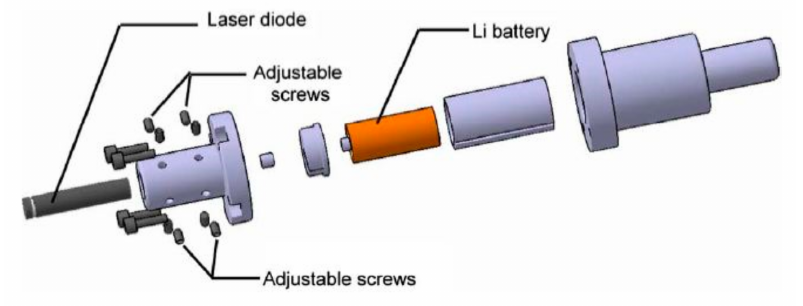
Figure 28. Exploded view of a holder with a laser diode